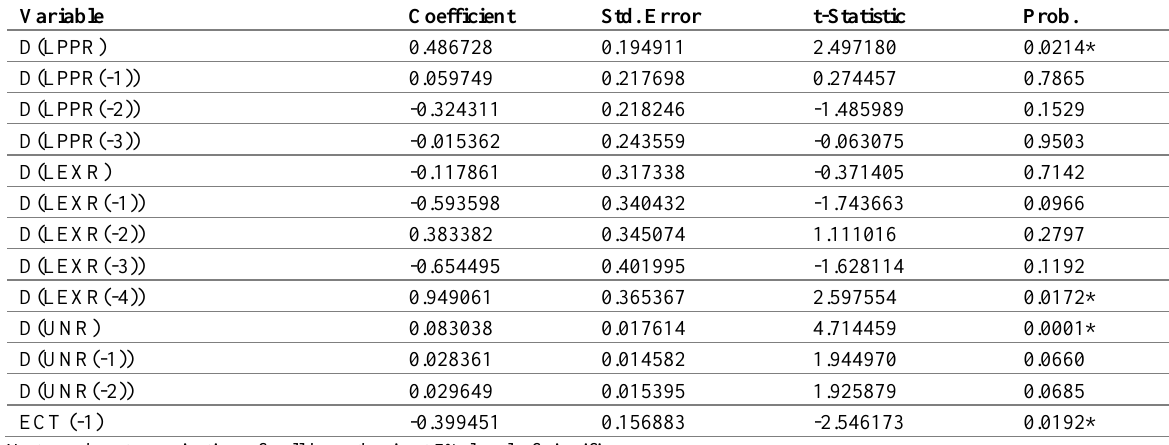
Table 5: Error correction and short term dynamics